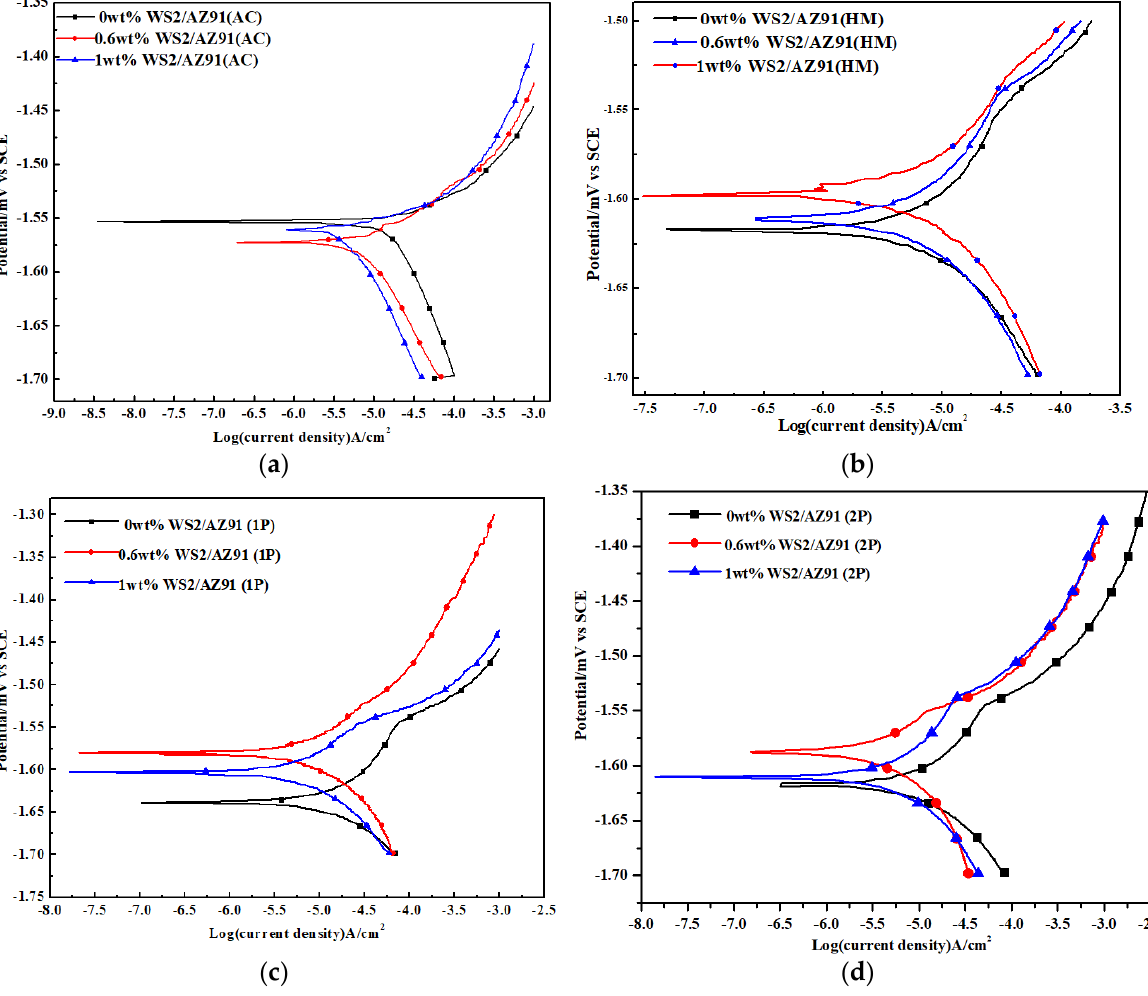
Figure 2. Tafel curves for WS 2 /AZ91 composites in ( a ) as ‐ cast, ( b ) homogenized, ( c ) one ‐ pass ECAP, ( d ) two ‐ pass ECAP.